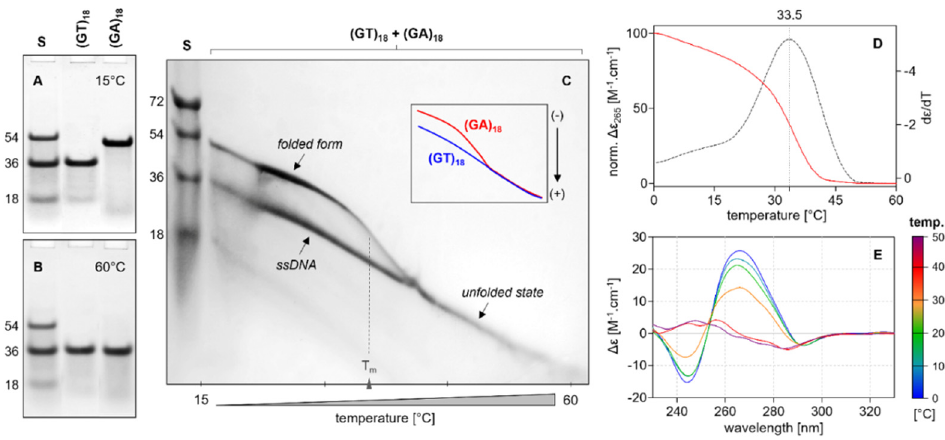
Figure 7. Electrophoretic analysis of (GT) 18 and (GA) 18 in mBR in the presence of 50 mM KCl. Electro- phoretic records in standard 12% PAGE taken at two different temperatures, ( A ) 15 °C and ( B ) 60 °C, at which DNA occurs in folded and unfolded states, see also Supplementary Figure S4. The tempera- ture of 60 °C is higher than the melting temperature of (GA) 18 . Molecular standard S is a mixture of oligonucleotides d(AC) 9 , d(AC) 18 , and d(AC) 27 . ( C ) Electrophoretic separation of equimolar (GT) 18 and (GA) 18 in a temperature gradient perpendicular to electrophoretic motion (TGGE). The results clearly show that the mobility of the dimer (GA) 18 after melting is equivalent to that of the unstructured (GT) 18 . In order to eliminate unexpected pairing between DNA samples, (GT) 18 was loaded onto the gel 5 min earlier than (GA) 18 . The inset shows a schematic representation of sample mobilities in the temperature gradient. ( D ) CD melting curve of (GA) 18 under the same conditions as for PAGE and TGGE (red line) and the first derivative function of the melting curve (dotted line). ( E ) CD spectra collected at different temperatures where the increment is 10 °C.